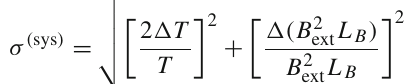
tivity above ≈ 30 Hz is [31] S ψ ≈ RIN (ν m )